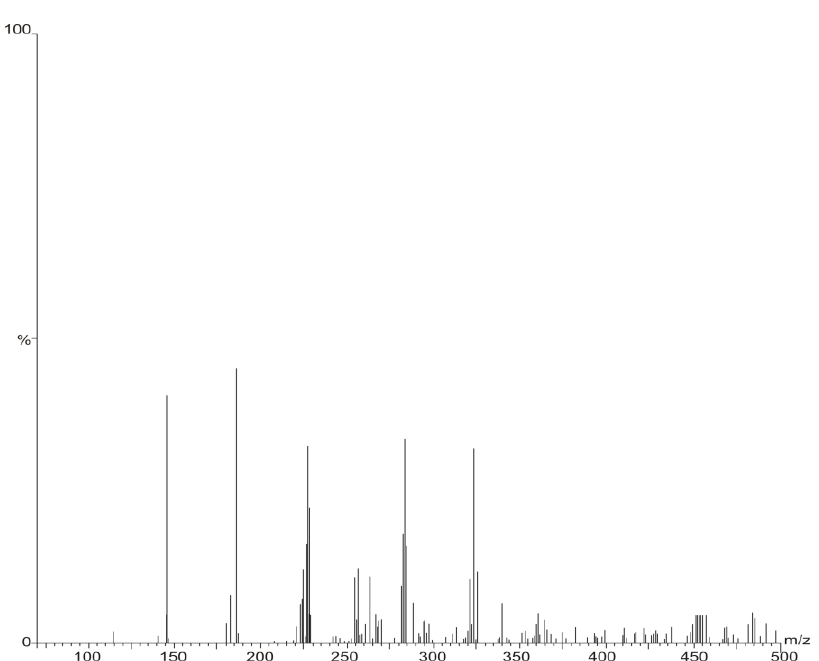
Figure 2b. Mass spectrum of the complex